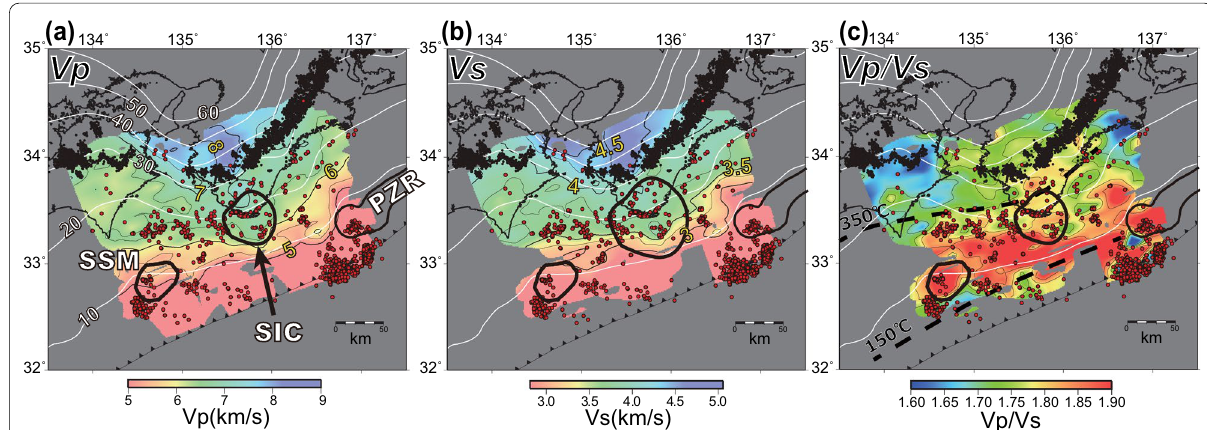
Fig. 8 The estimated velocity structure along the plate interface. Red and black dots reflect the relocated hypocenters within 2.5 km from the plate interface and the deep low-frequency tremor (Maeda and Obara 2009; Obara et al. 2010), respectively. White contours show the iso-depth of plate interface with a 10 km increment (Nakanishi et al. 2018). a P-wave velocity structure. Black lines show the iso-velocity contours from 5 to 8 km/s with 0.5 km/s increments. b S-wave velocity structure. Black lines show the iso-velocity contours from 3 to 4.5 km/s with 0.25 km/s increments. c Vp/ Vs structure. Black lines show the iso-value contours from 1.7 to 1.9 with 0.1 increments. Thick dashed lines correspond to the isotherm contour for 150 and 350 °C (Oleskevich et al. 1999). Other symbols are the same as Fig.